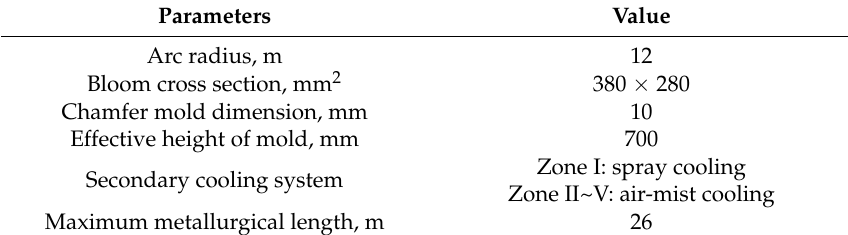
Table 1. Parameters of the bloom caster (SC: Slow cooling; SSC: Super-slow cooling).